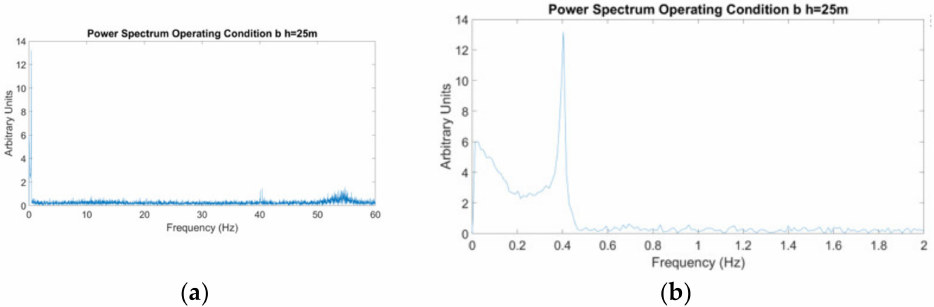
Figure 12. Spectrum of vibration frequencies of point P on the wind tower located at H = 25 m. Data have been collected during the deactivation of the turbine ( a ). Enlargement of the low frequencies ( b ).